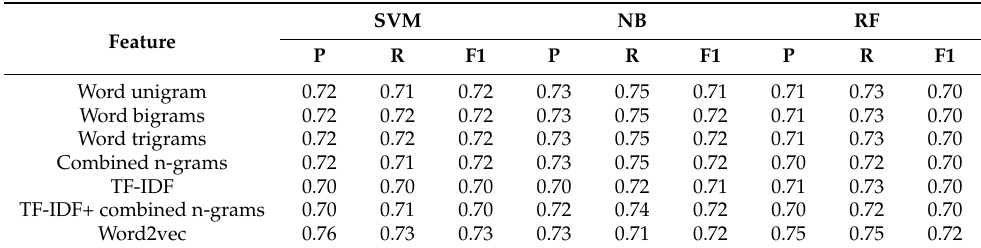
Table 10. Classification performance result of binary models.